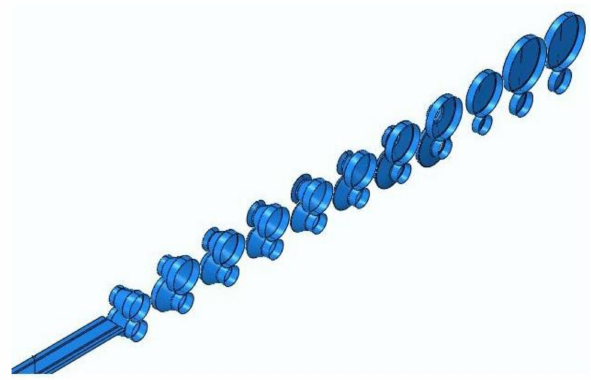
Figure 10. The geometric model of